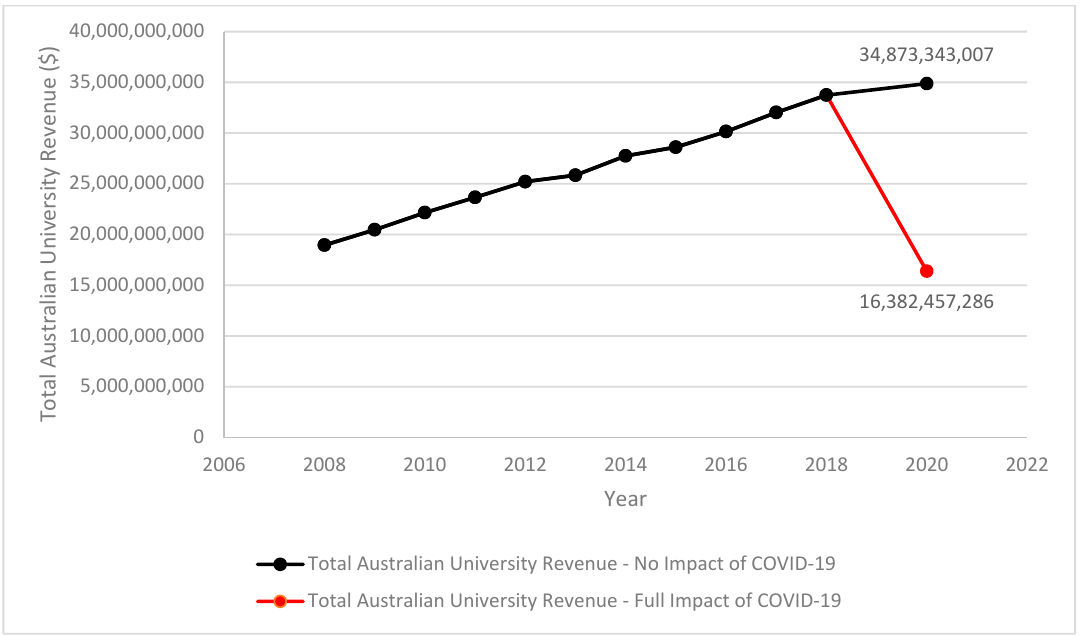
Figure 6. Impact of COVID-19 on Total Australian University Revenue.